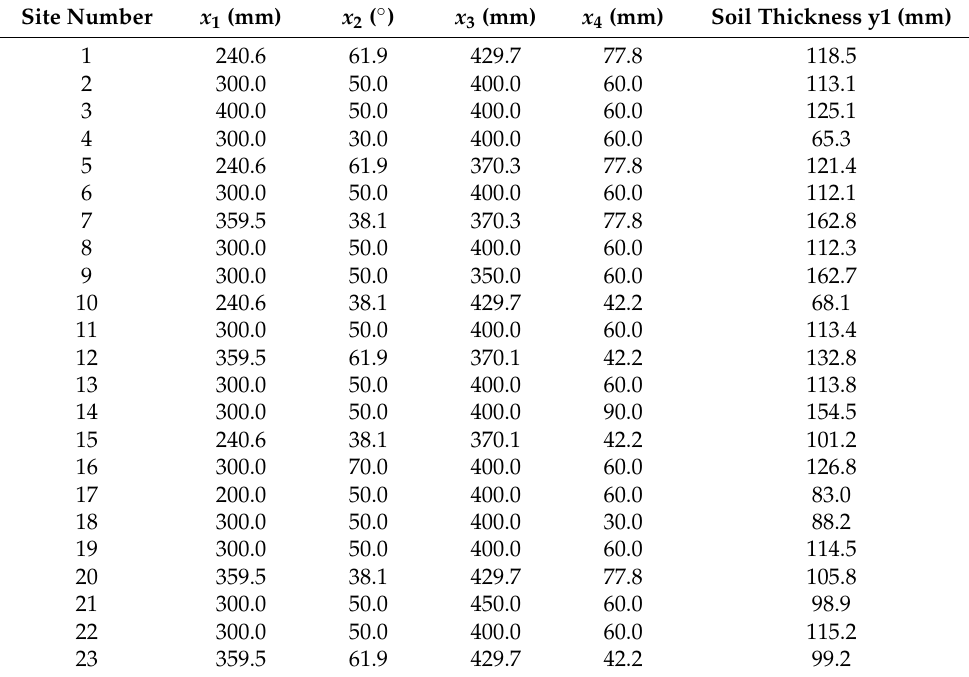
Table 4. The results of the quadratic orthogonal rotation regression